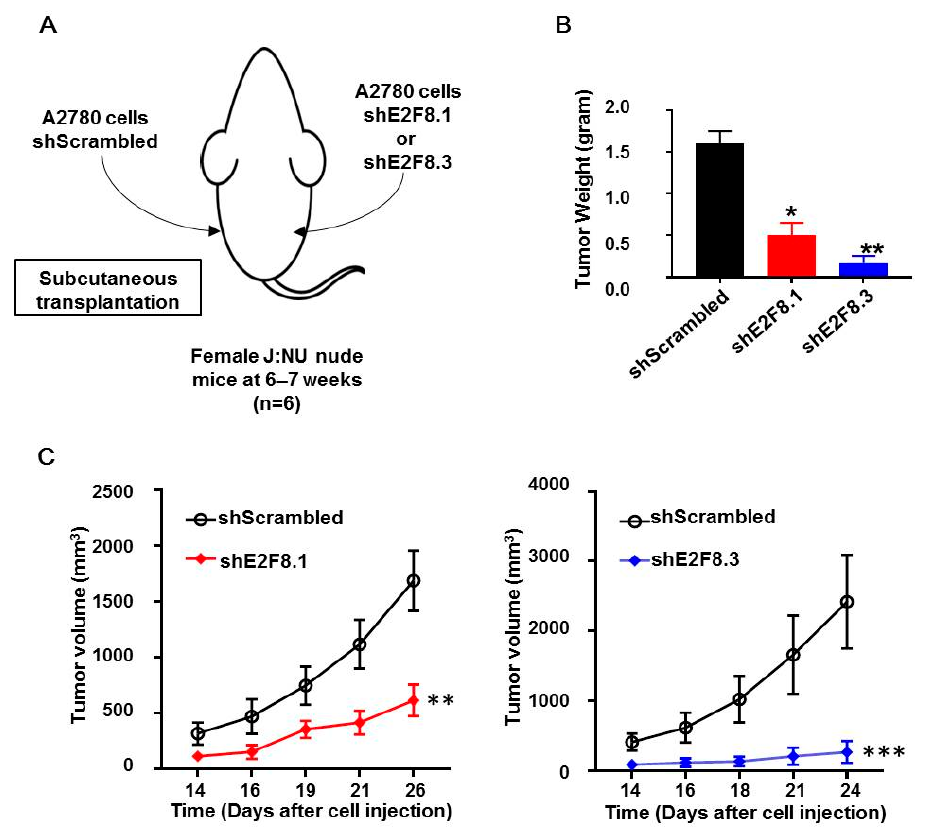
Figure 4. E2F8-knockdown decreases tumor size in xenograft nude mouse model. ( A ) A2780 cells transfected with shE2F8.1 or shE2F8.3 or shScrambled were injected subcutaneously into the right or left flanks of female J:NU nude mice at 6–7 weeks. ( B ) Tumor weights were compared after harvesting tumors. ( C ) Tumor sizes were serially measured and compared. * p < 0.05, ** p < 0.01, *** p < 0.001, vs. shScrambled.